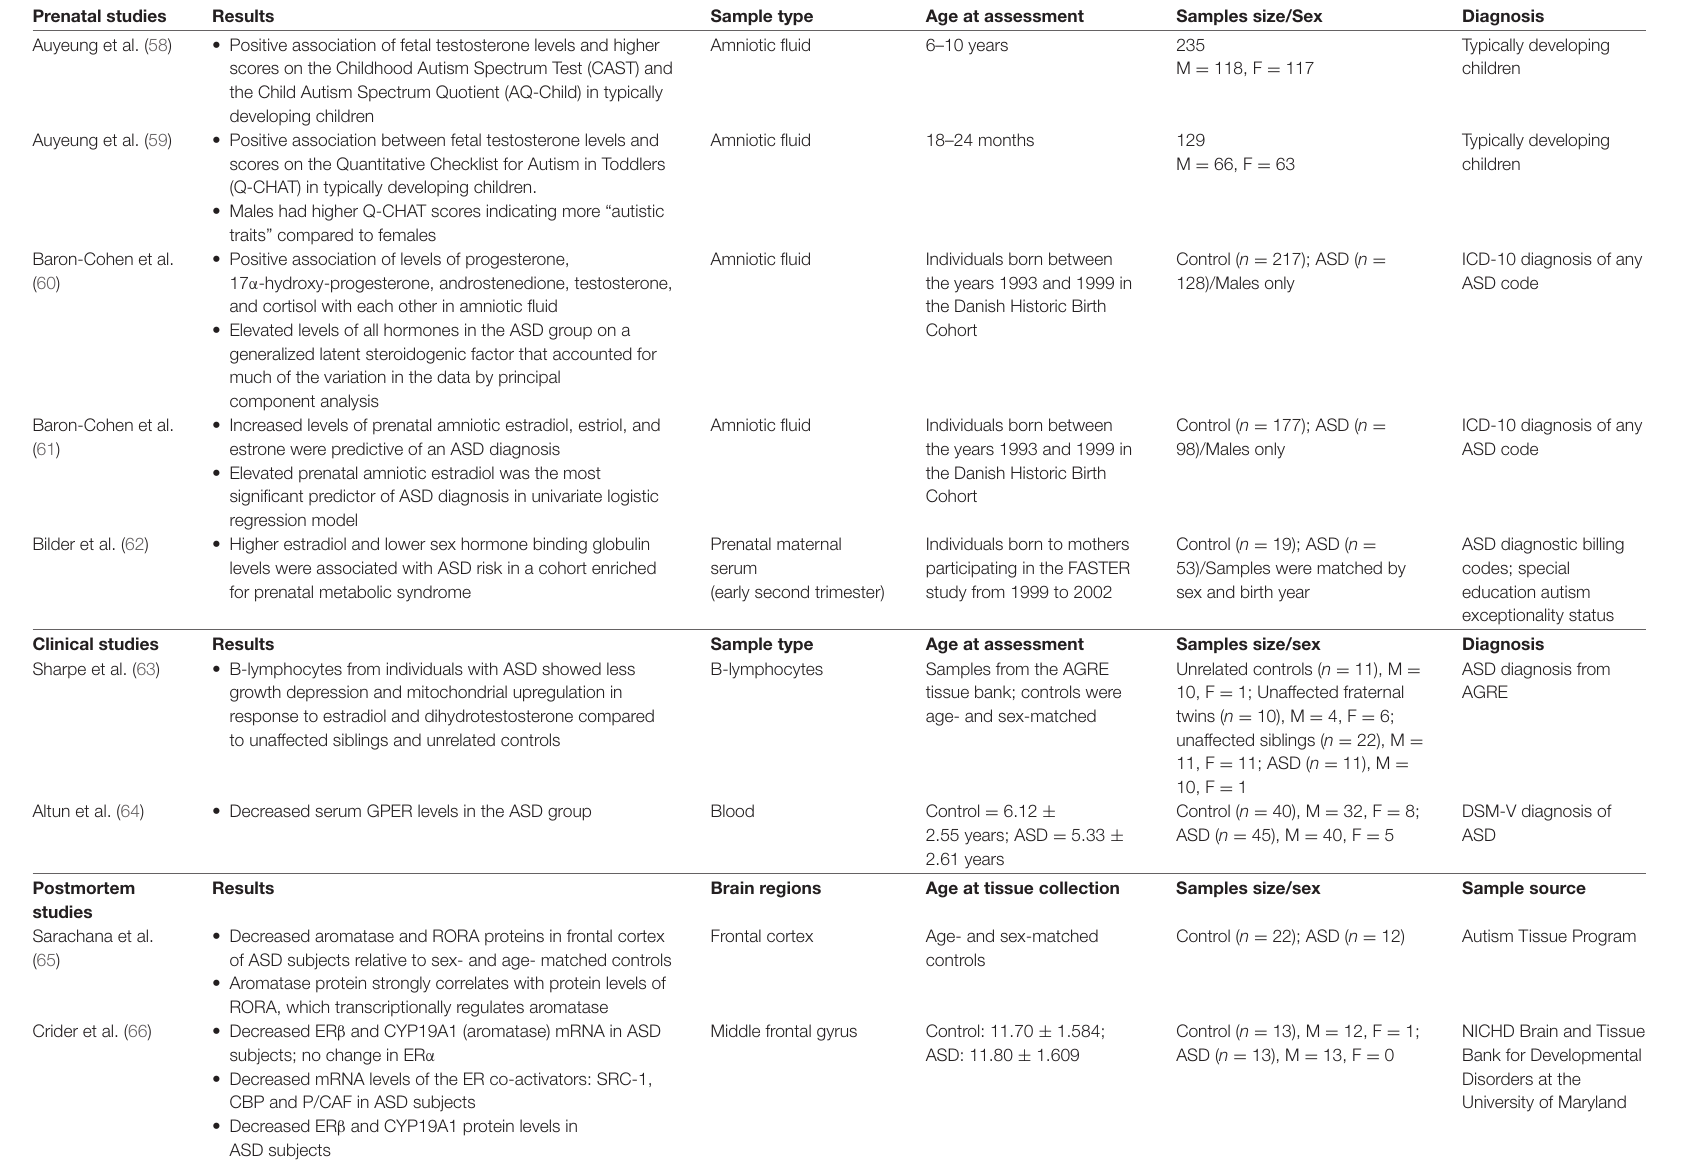
TABLE 1 | Clinical and postmortem studies of sex steroid hormones in autism spectrum